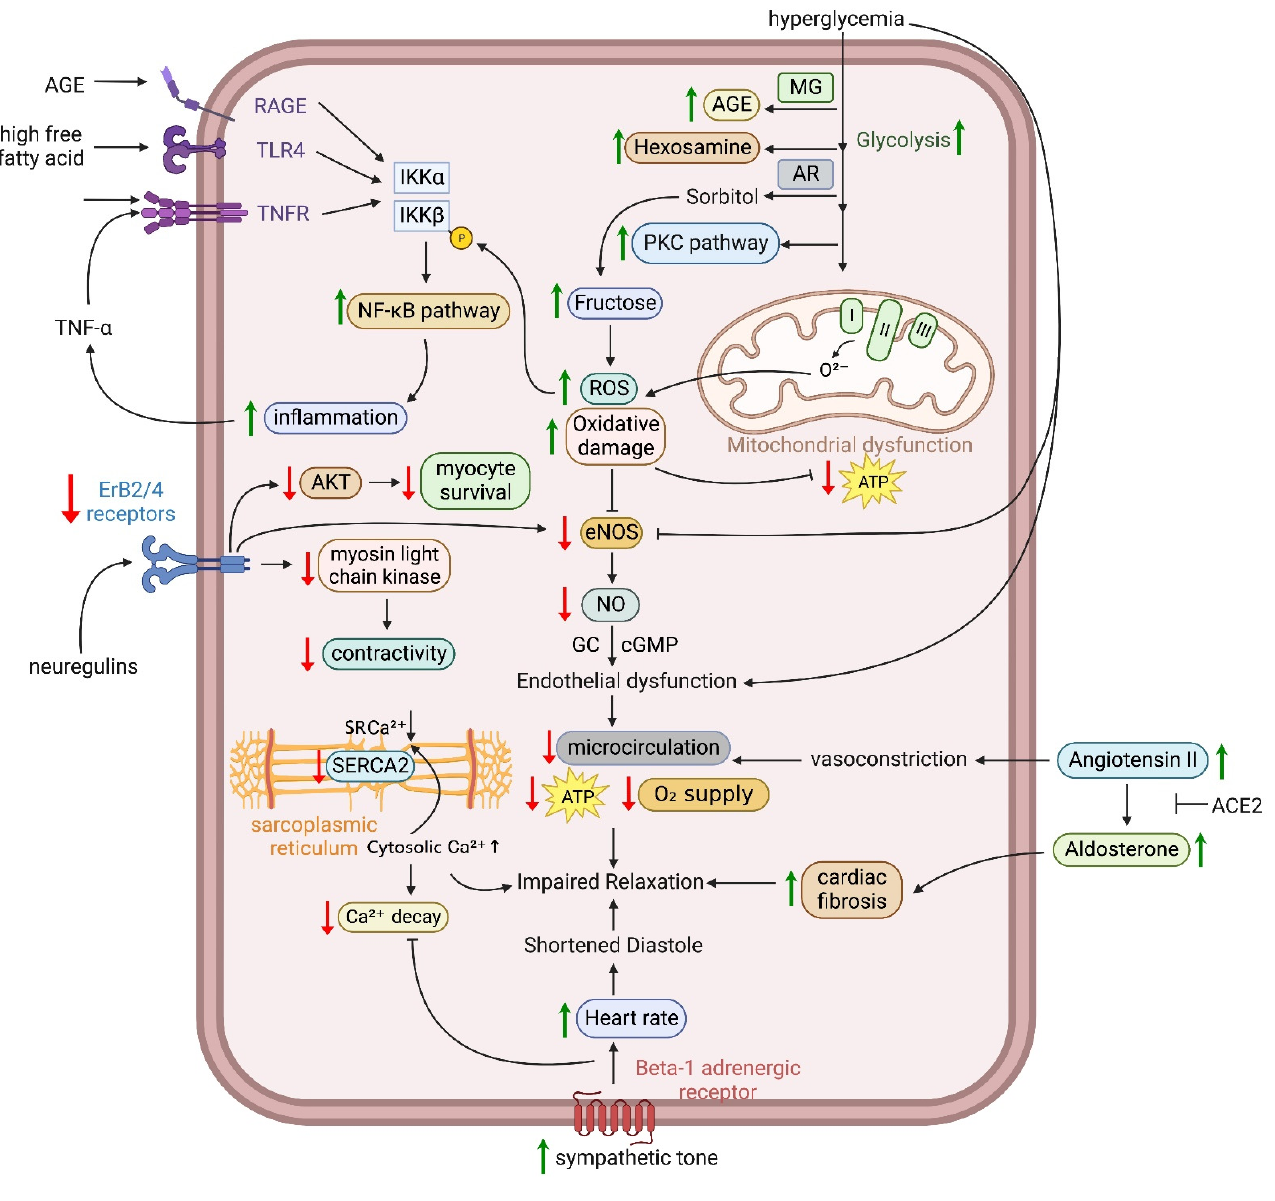
Figure 2. Oxidative stress, inflammation, impaired calcium homeostasis, abnormal endothelial func- tion and nitric oxide production, aberrant epidermal growth factor receptor singling, and activation of the renin–angiotensin–aldosterone and sympathetic systemsin the pathogenesis of diabetic cardiomy- opathy. MG: methylglyoxal, AGE: advanced glycation end-products, AR: aldose reductase, PKC: protein kinase C; ROS: reactive oxygen species; RAGE: receptor for advanced glycation end-products; TRL4: toll-like receptor 4; TNFR: tumor necrosis factor receptor; NF- κ B: nuclear factor kappa-B; TNF- α : tumor necrosis factor- α ; GC: guanylate cyclase; eNOS: constitutive nitric oxide synthase; ErbB2/4 (v-erb-b2 avian erythroblastic leukemia viral oncogene homolog 2); NOX: NADPH oxidase; ACE2: angiotensin-converting enzyme 2; SERCA2a: sarcoplasmic reticulum Ca 2+ -ATPase 2a; NO: nitric oxide; ATP: adenosine triphosphate, IKK: I κ B kinase; SR: sarcoplasmic retic- ulum.